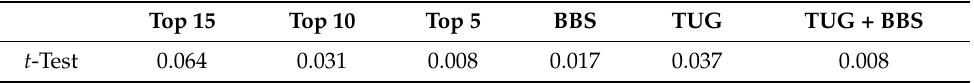
Table 9. t -test p -values for the comparison of including or excluding MSE from the feature